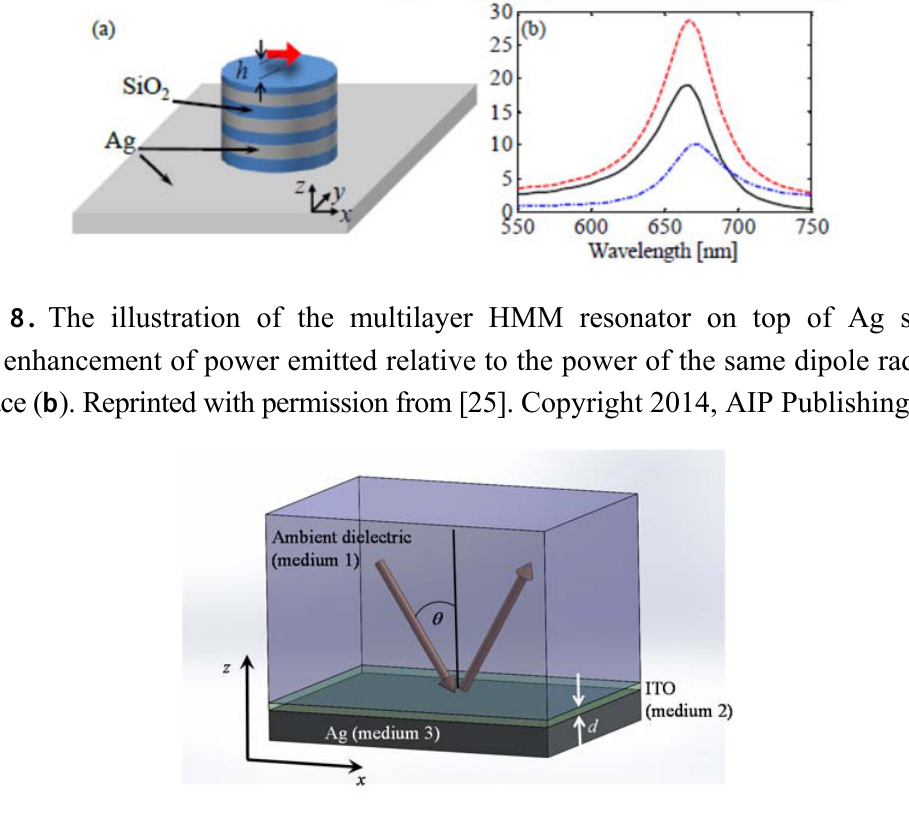
Figure 9. Schematic depiction of a three-medium structure comprising an ambient dielectric (medium 1), a subwavelength ITO layer of thickness d (medium 2) and a metallic substrate (medium 3). Reprinted with permission from [29].